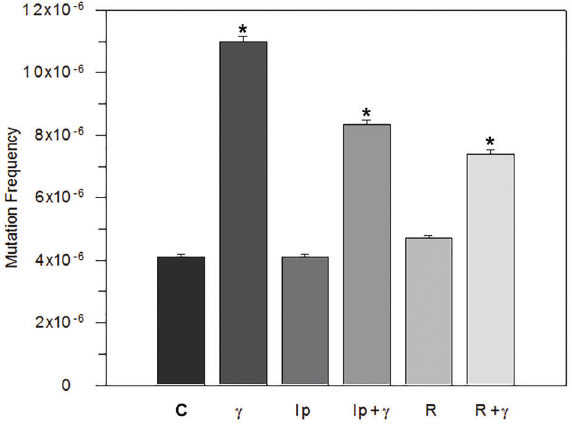
Figure 5. Mutation frequency of strain SC7K lys2-3 after exposure to gamma rays ( g ) at 200Gy and upon concomitant exposure to Ilex paraguariensis (Ip) and rutin (R). C: control group. Data from at least three reproducible experiments are reported as means ± SD. *P o 0.05 (binomial